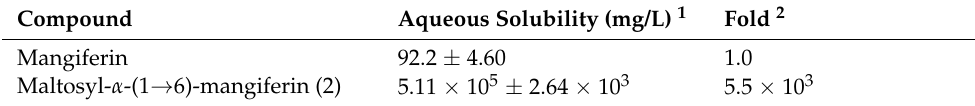
Table 1. Aqueous solubility of mangiferin and maltosyl- α -(1 → 6)-mangiferin ( 2 ). Compound